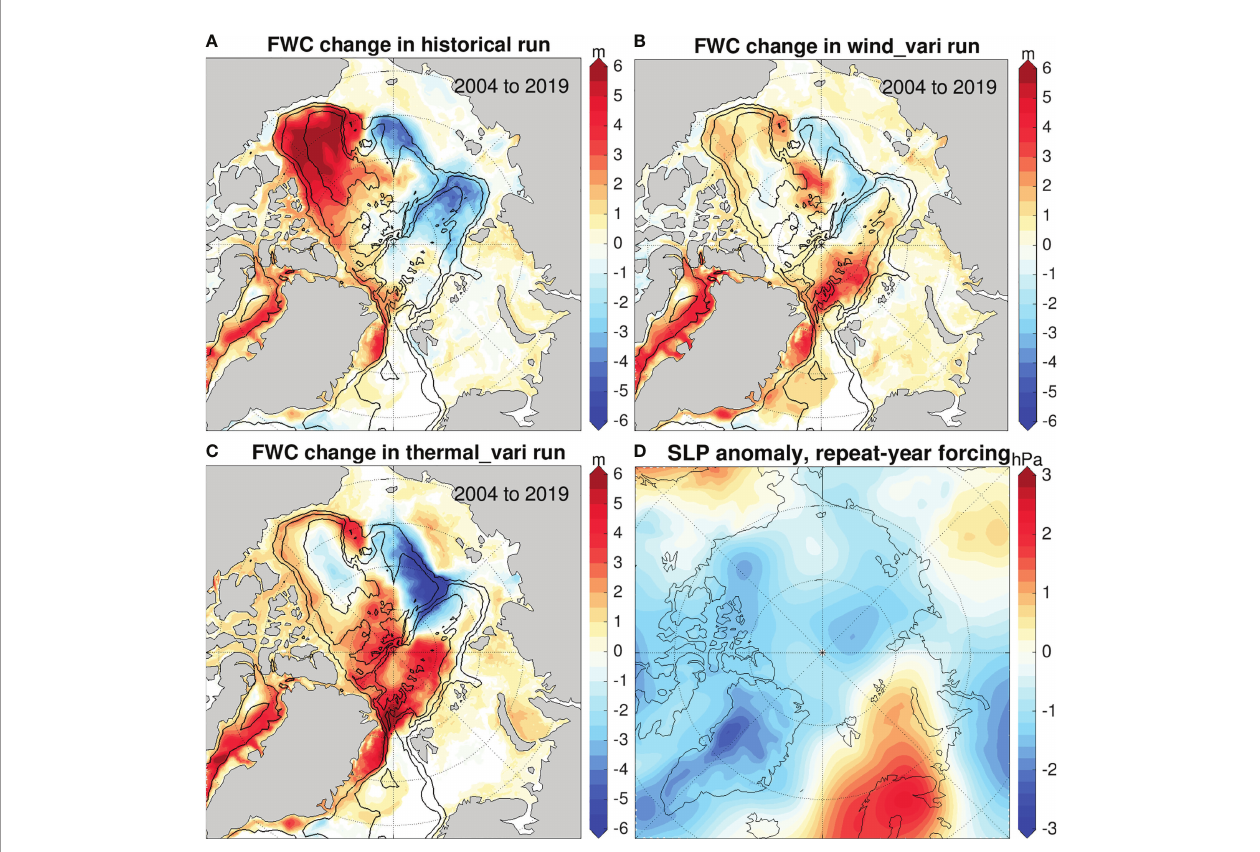
FIGURE 11 | The unusual winds and sea ice decline jointly drove the freshwater content change in the early 21st century. (A) Change in freshwater content (FWC, m) from 2004 to 2019 in the historical simulation. (B) The same as (A) , but in the wind_vari simulation. (C) The same as (A) , but for the thermal_vari simulation. (D) The annual mean sea level pressure (SLP) anomaly in the repeat-year forcing relative to the 1980 – 2019 mean SLP of the reanalysis data; Winds from this forcing are used in the thermal_vari simulation. This fi gure shows that the spatial pattern of Arctic Ocean FWC will become very different without either of the two controlling factors (unusual winds and sea ice